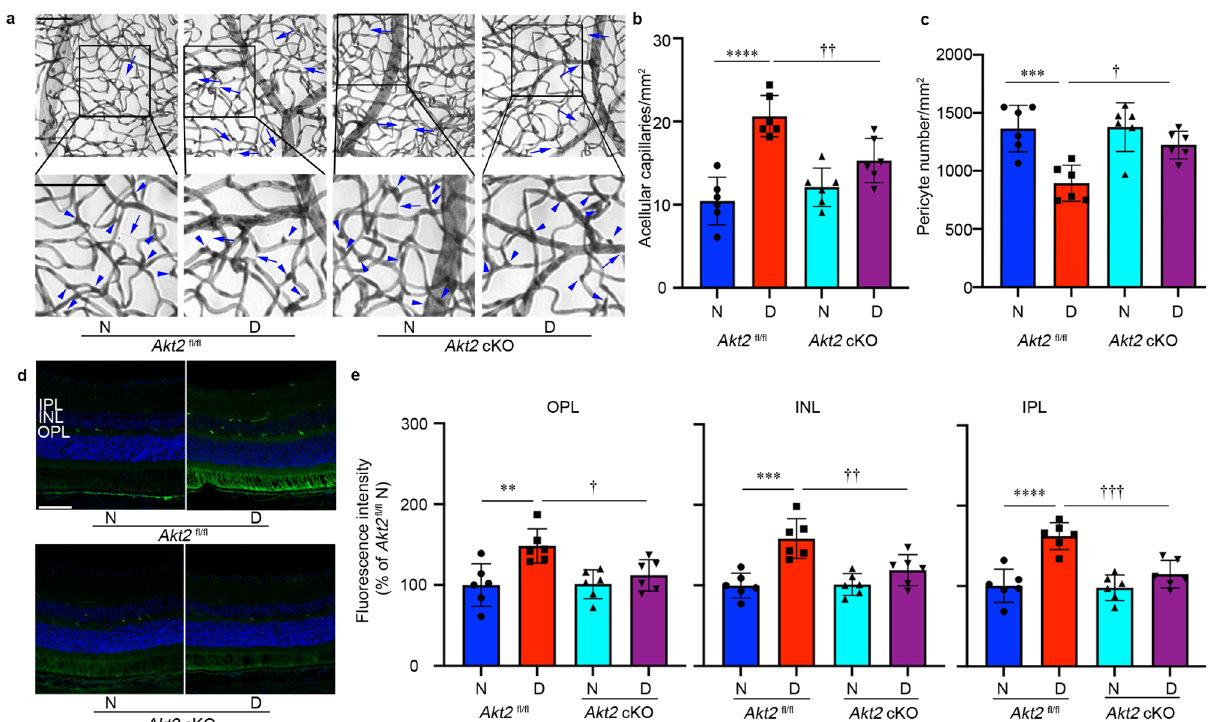
Fig. 4 | RPE-speci fi c Akt2 cKO inhibits the development of diabetes-induced retinal vascular lesions. a Representative micrographs of retinal vessels from diabetic mice (8 months of diabetes) and age-matched nondiabetic mice. Arrows indicate degenerated capillaries and arrowheads indicate capillary pericytes. Scale bar: 100 µ m. b Diabetes increased the number of degenerated capillaries and ( c ) decreased the number of retinal capillary pericytes in diabetic Akt2 fl / fl mice com- pared to nondiabetic animals. RPE-speci fi c Akt2 cKO partially rescued this degen- eration. d Representative micrographs of retinal sections after mice were intravenously injected with FITC-albumin. Scale bar: 100 µ m. e Average fl uores- cence intensity was quanti fi ed from a large area of INL, IPL, and OPL, excluding obvious microvessels. RPE-speci fi c Akt2 cKO reduced the diabetes-induced